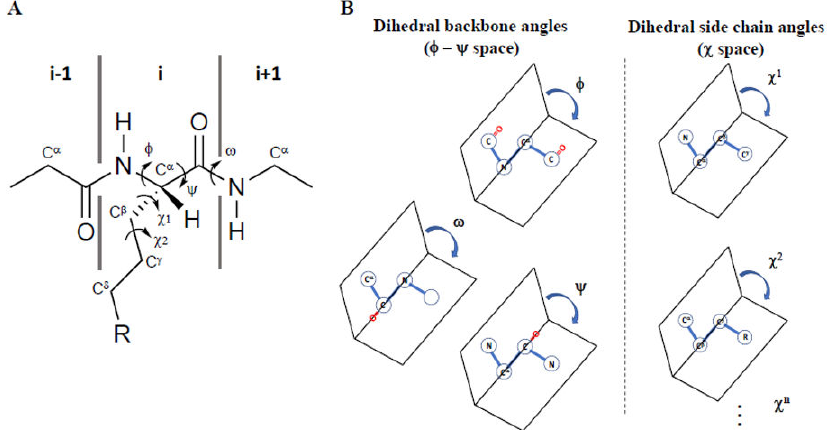
Figure 1. ( A ) Representation of the ϕ , ψ , ω , χ 1 , and χ 2 torsional angles in a peptide, and ( B ) their definition as dihedral angles in 3D space, adapted from Ref.